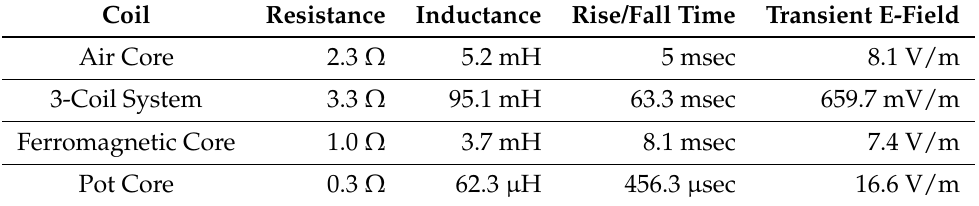
Table 2. Electrical parameters of the stimulation coils. Rise/Fall time indicates the time required to transition between 10% to 90%, or 90% to 10%, stimulation strength when the stimulation switches on or off. The transient E-field is estimated by Faraday’s Law of induction during these periods, where the change in flux is estimated based on the predicted experimental 15 A | B | reported in Figure